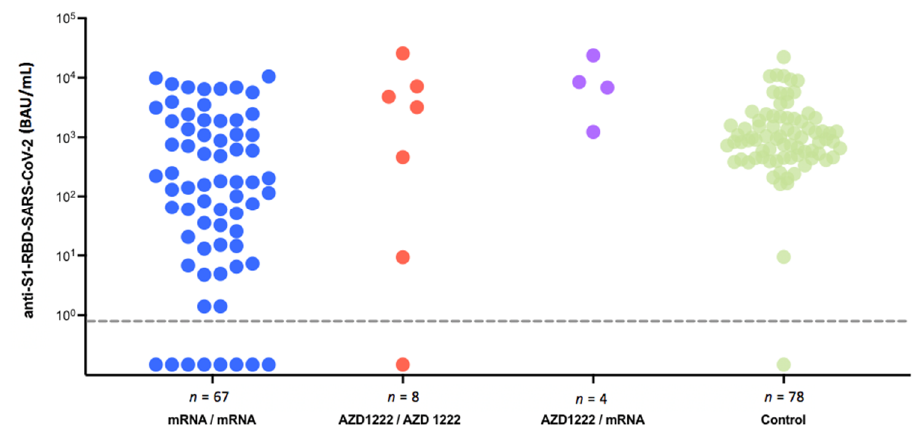
Figure 3. Serological response depending on vaccination type.